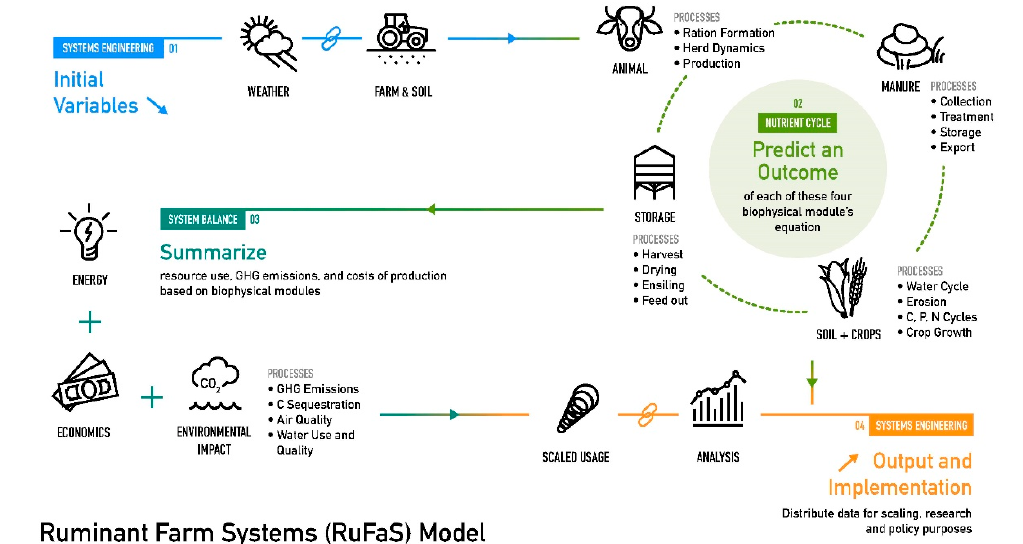
Figure 1. Conceptual diagram of the Ruminant Farm Systems Model.